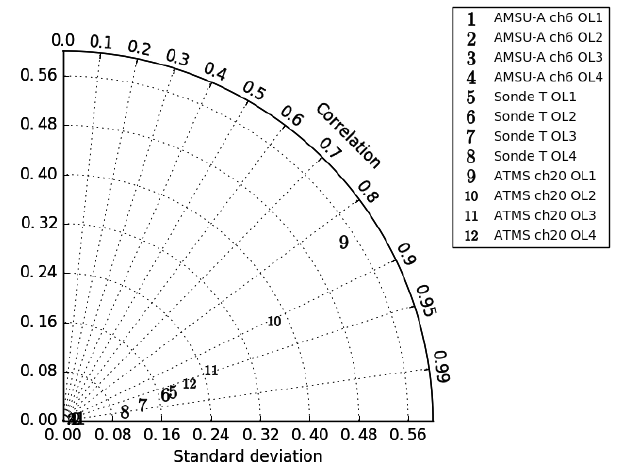
Figure 4. Taylor diagram showing the correlation (azimuthal an- gle) and standard deviation (distance from the origin) of the dif- ferences in the departures (K) between the nonlinear trajectory and linear minimisation steps for each outer loop. Results are shown for satellite brightness temperature observations (ASMU-A channel 6, ATMS channel 20) and radiosonde temperature